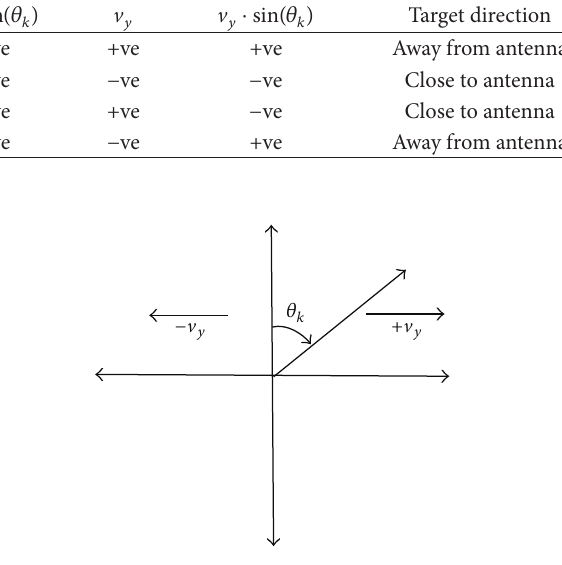
Figure 3: Target direction dependence on V 𝑦 and 𝜃 𝑘